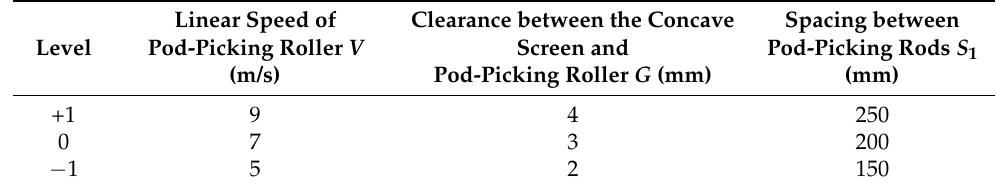
Table 2. Testing factor